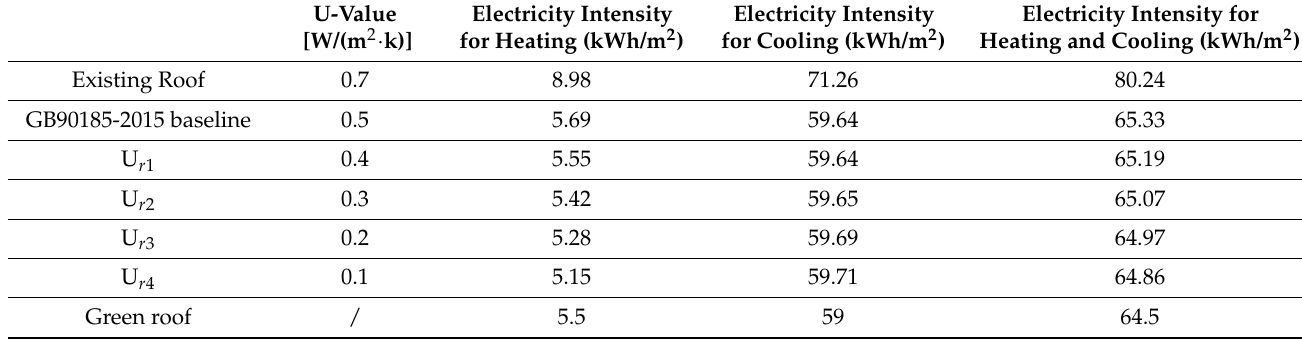
Table 8. Energy simulation results of using different U-values and green roof energy